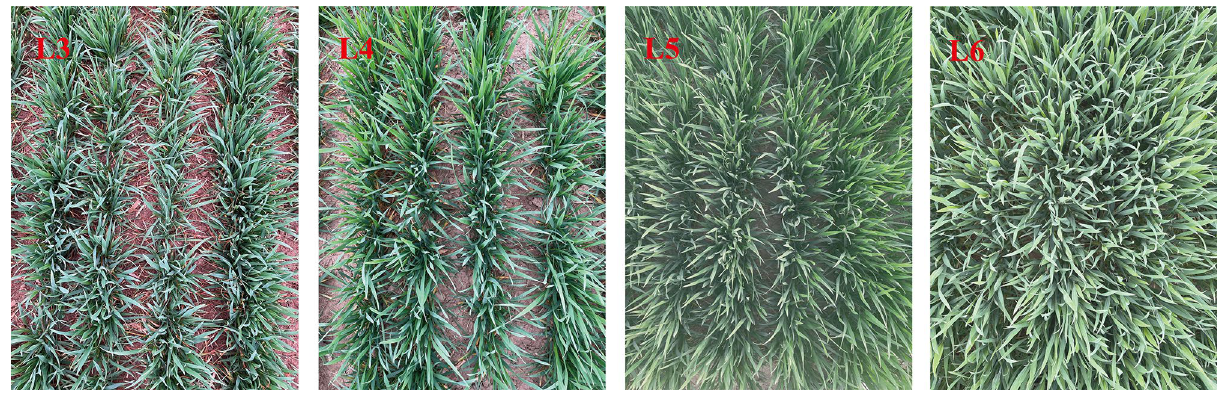
Figure 2. The winter wheat growth condition of the four irrigation timesWheat field growth before spring